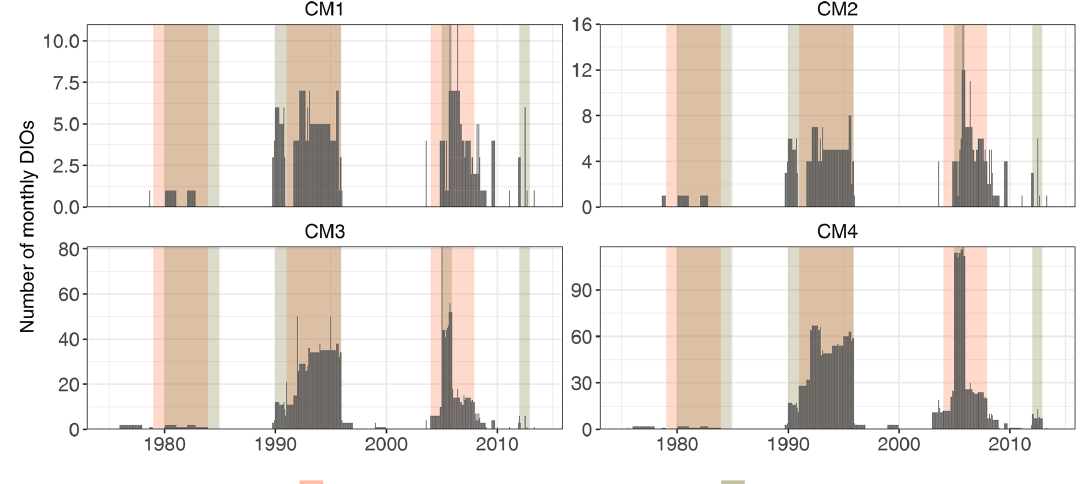
Figure 2. Total monthly DIOs in Spain (bars) from 1975 to 2013, using different counting methods (CM1–CM4). Important historical drought periods identified in other studies are highlighted.